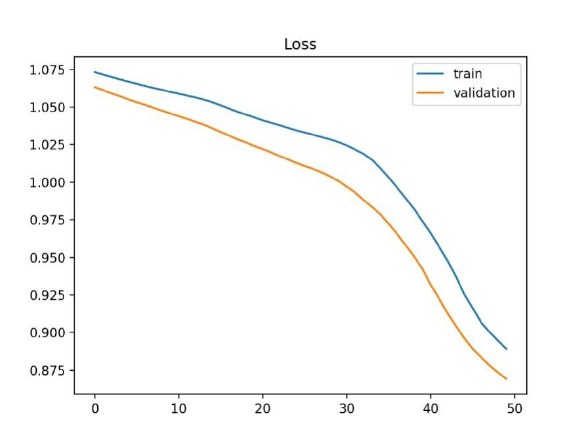
Fig. 2 Training performance curve of the